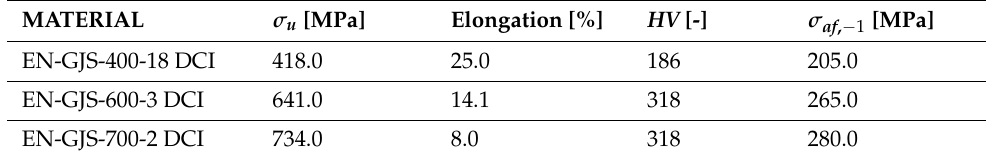
Table 2. Mechanical and fatigue properties of the three DCIs examined